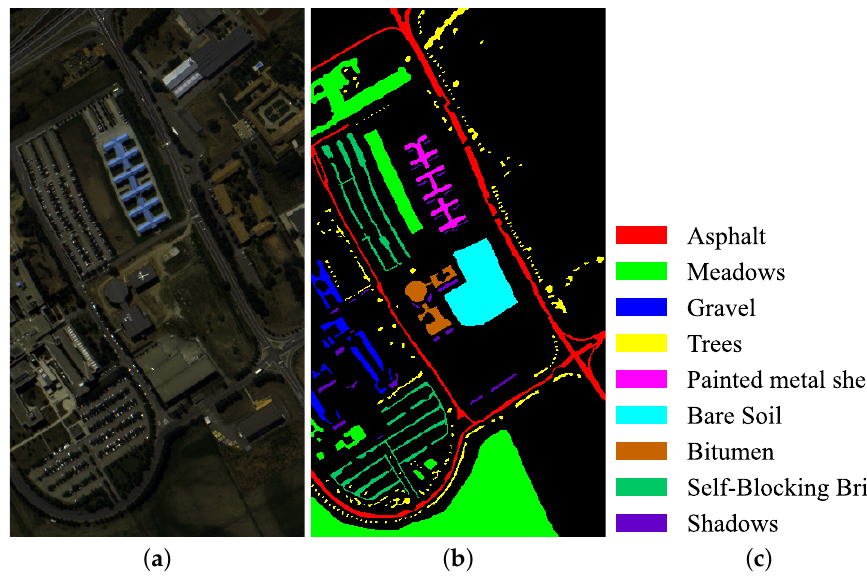
Figure 5. False color image and ground truth image of the UP dataset. ( a ) False color image. ( b ) Ground truth image. ( c ) Color coding for each category.